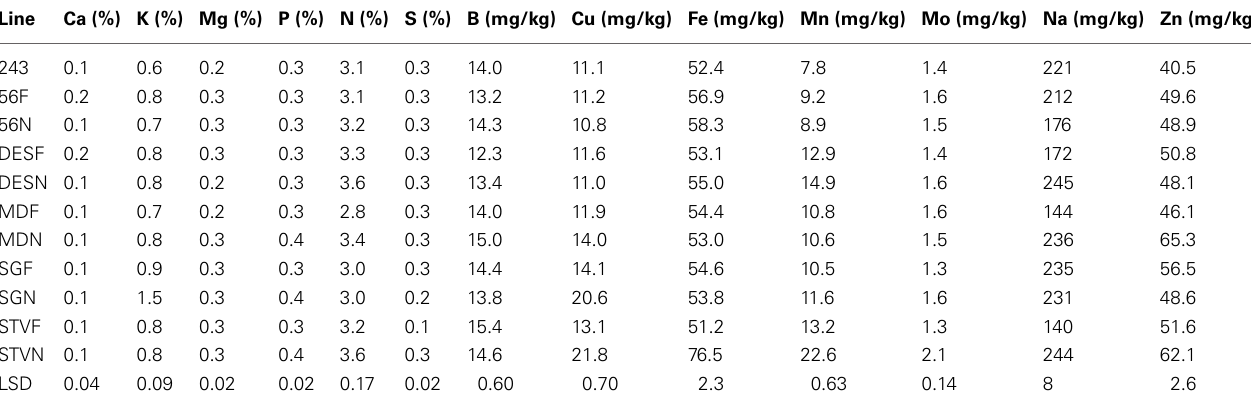
Table 7 | Characterization of cottonseed nutrients composition as influenced by fuzz (F) and fuzzless (N) seed trait in cotton isogenic mutant lines under water stress conditions ∗